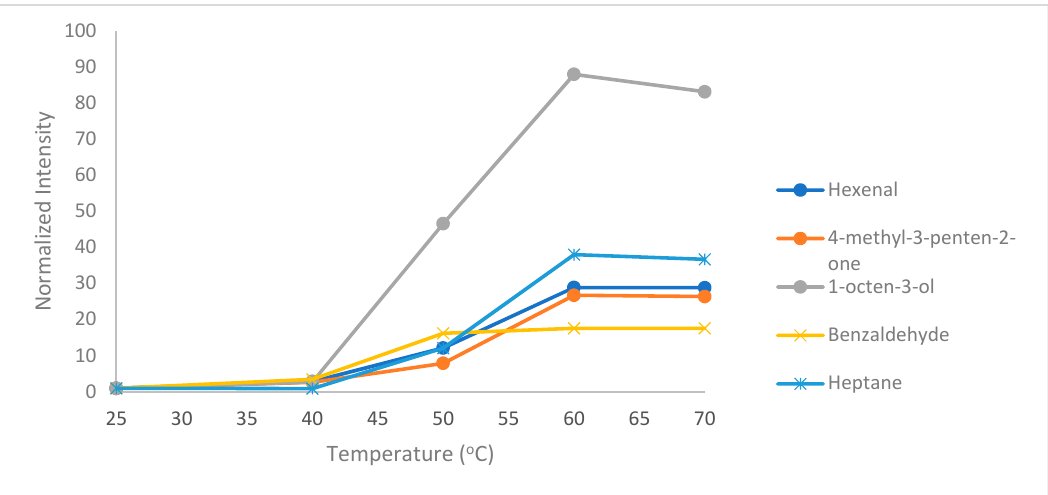
Figure 2. Effect of extraction temperature on hexanal, 4-methyl-3-penten-2-one, heptane, benzaldehyde and 1-octen-3-ol.